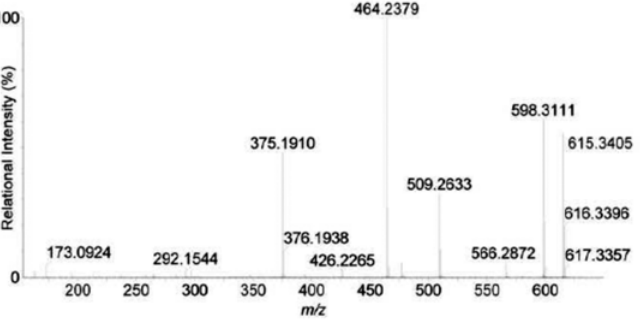
Fig 6. Liquid chromatogram-mass spectrum (LC-MS) profile of product B.